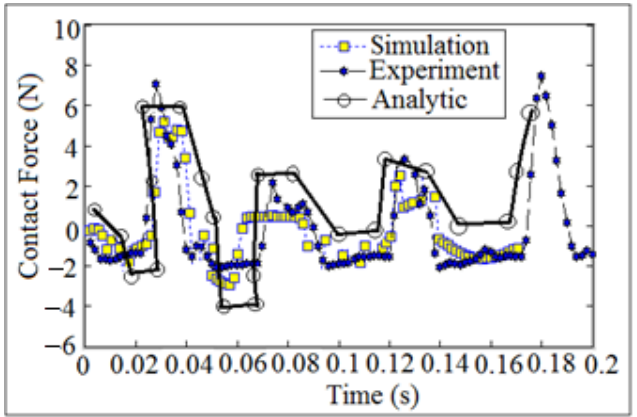
Figure 16. Comparison of contact force against time.